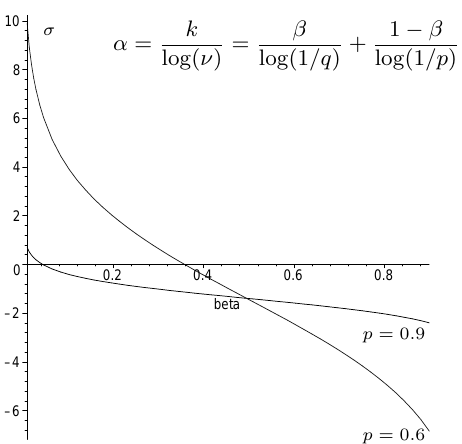
Fig. 3: The inverse Mellin integral gives p k, P ( ν ) when σ ∈ ] − 2 , 0[ (number of nodes present at depth k ), and − m k, P ( ν ) = − 2 k + p k, P ( ν ) when σ ∈ ]0 , + ∞ ] (num- ber of nodes missing at depth k